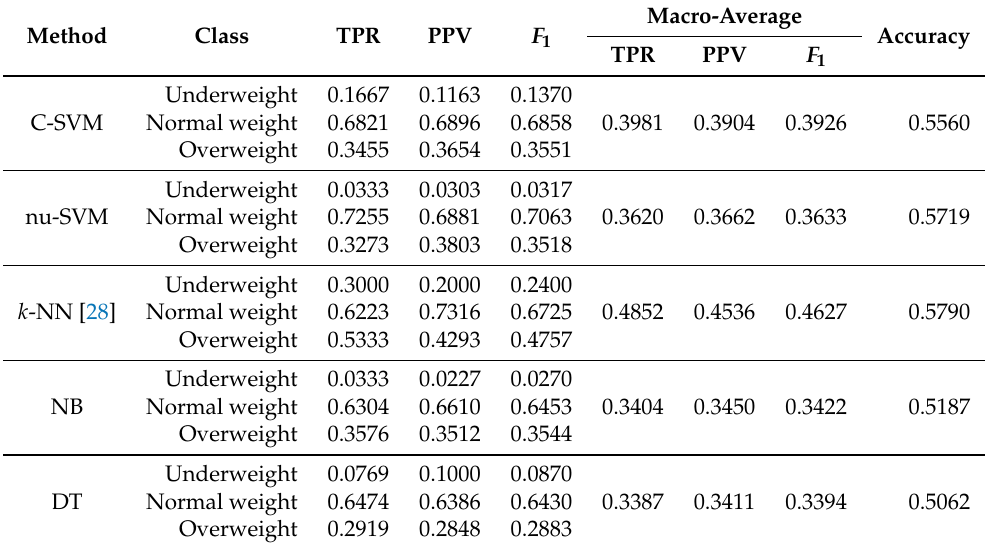
Table 11. Leave-one-person-out cross-validation results of the five benchmark methods when SMOTE is